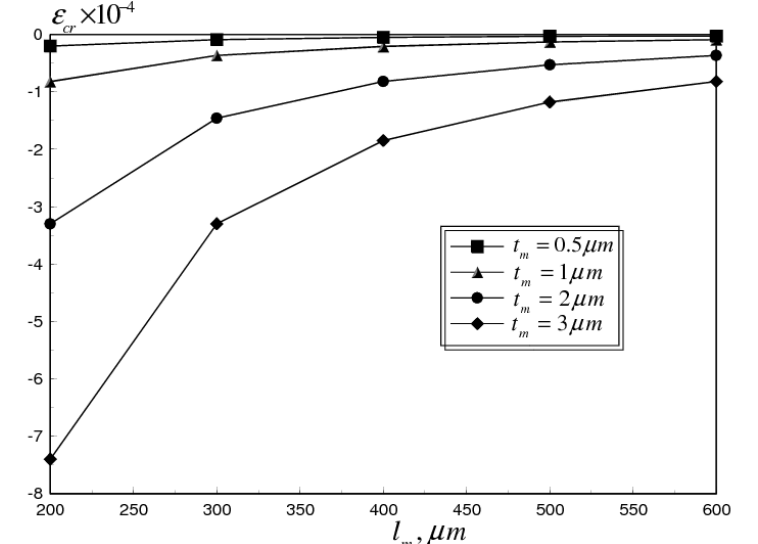
Figure 8. Critical buckling strain versus membrane length at different membrane thickness of flat aluminum RF MEMS